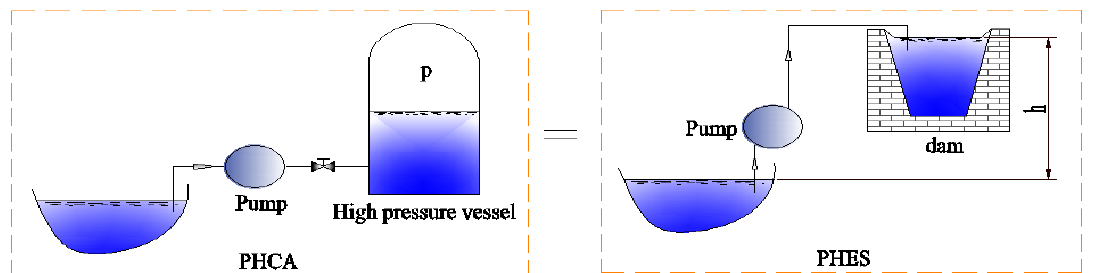
Figure 1. Physical model of the